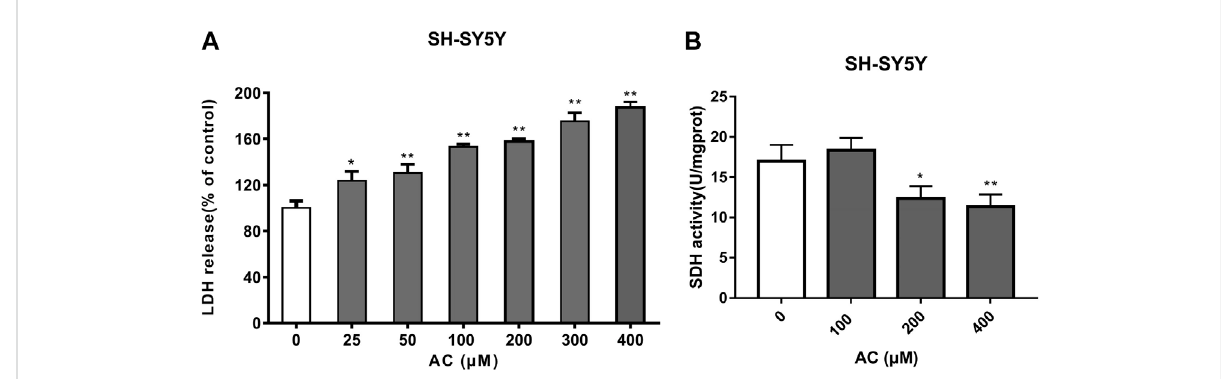
FIGURE 8 Effects of aconitine on mitochondrial function. (A) The release of LDH of SH-SY5Y cells after 24 h aconitine treatment. (* p < 0.05, ** p < 0.01 versus control group.) (B) The SDH activity of SH-SY5Y cells after 24 h aconitine treatment. (* p < 0.05, ** p < 0.01 versus control